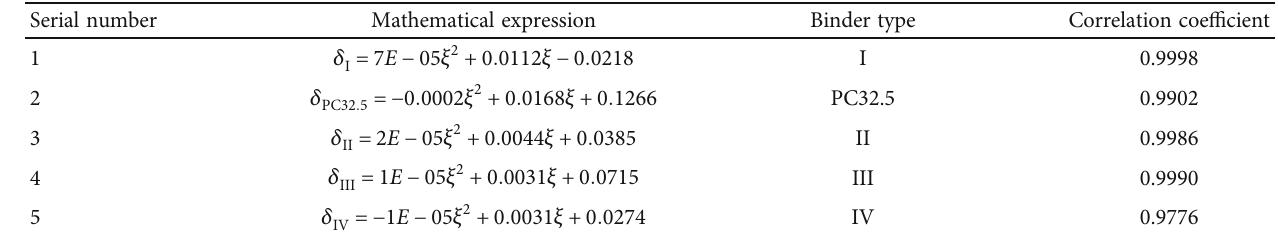
Table 8: Functional relationship of UCS and curing age (1